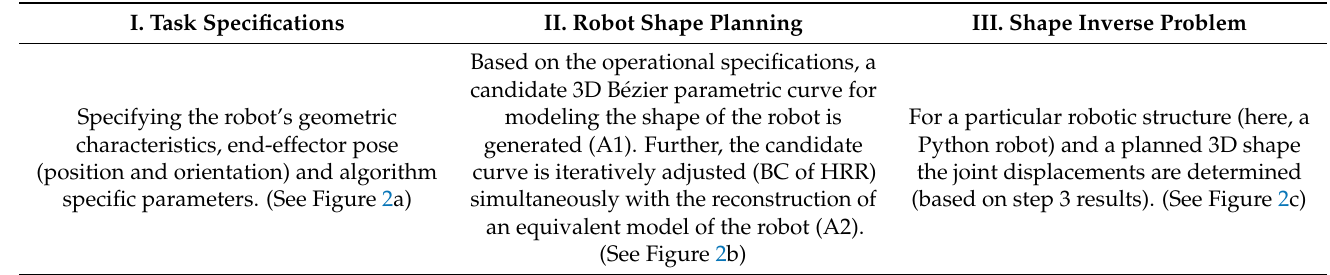
Table 1. S-GUIDE method. Short description and symbolic graphical representation of each method